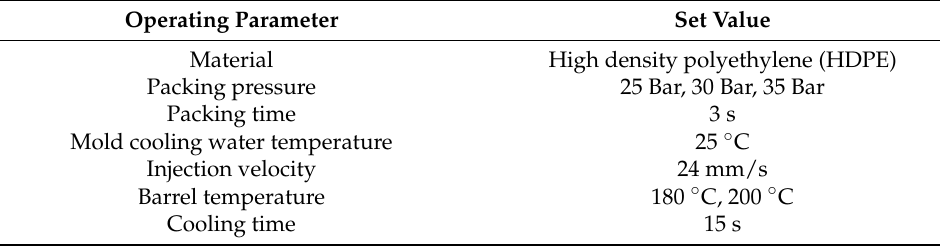
Table 1. Operating condition settings for injection molding process.